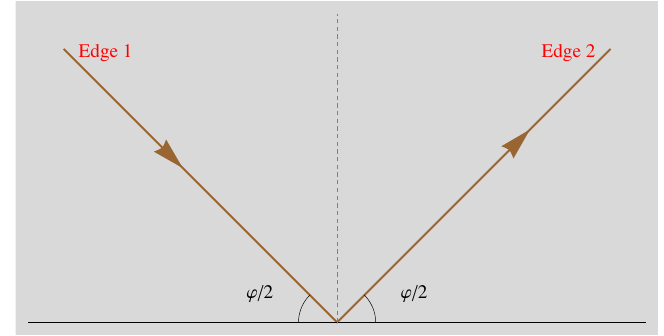
Figure 1 . Eq. (2.2) represents a planar cusp, whose angular extension is given by (cid:25) (cid:0) ’